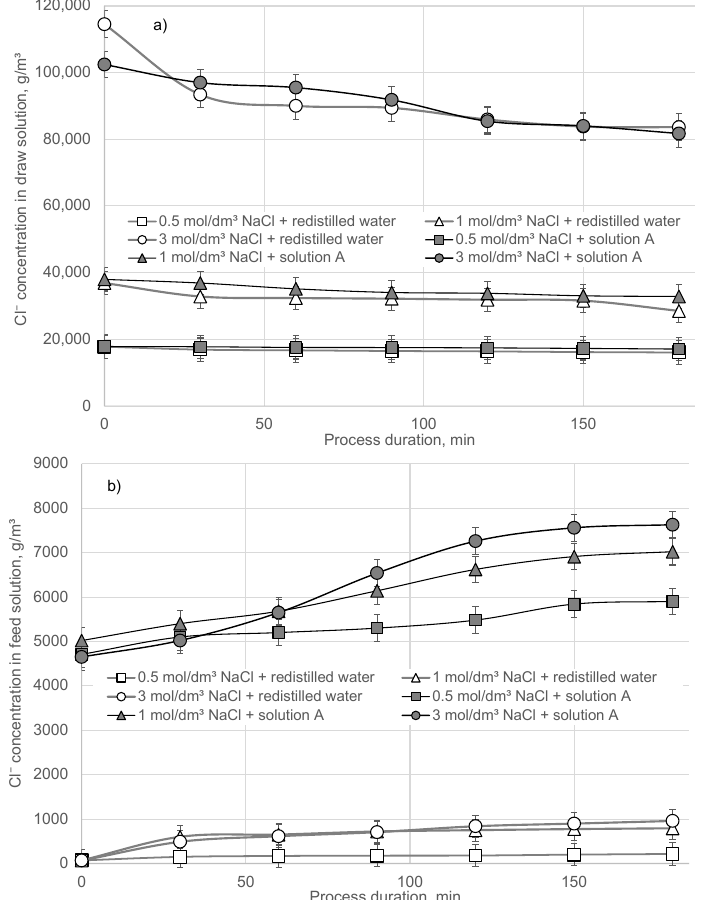
Figure 6. Changes of chloride concentration in: ( a ) the draw solution and ( b ) the feed solution with the FO process duration.